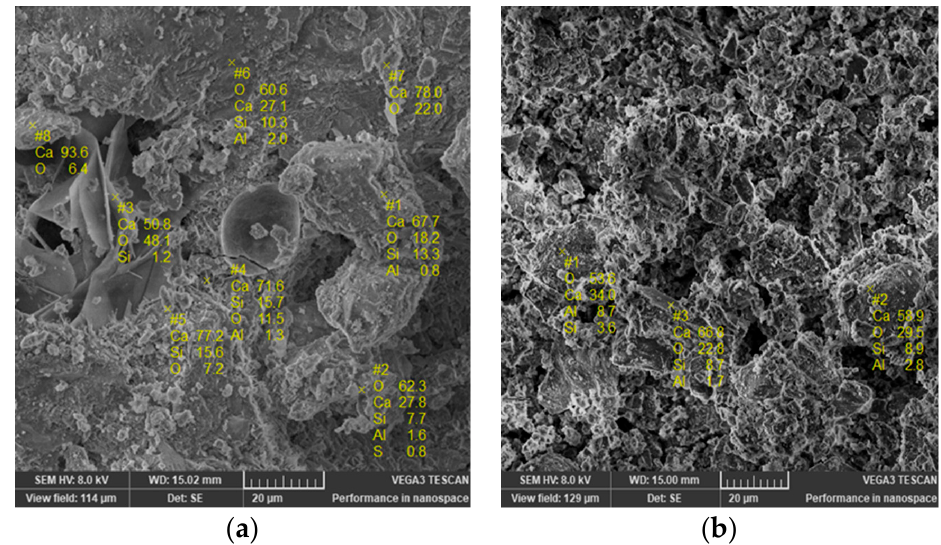
Figure 7. Surface topography and morphology of ( a ) CP and ( b ) CP10VSW samples at high magni- fication.